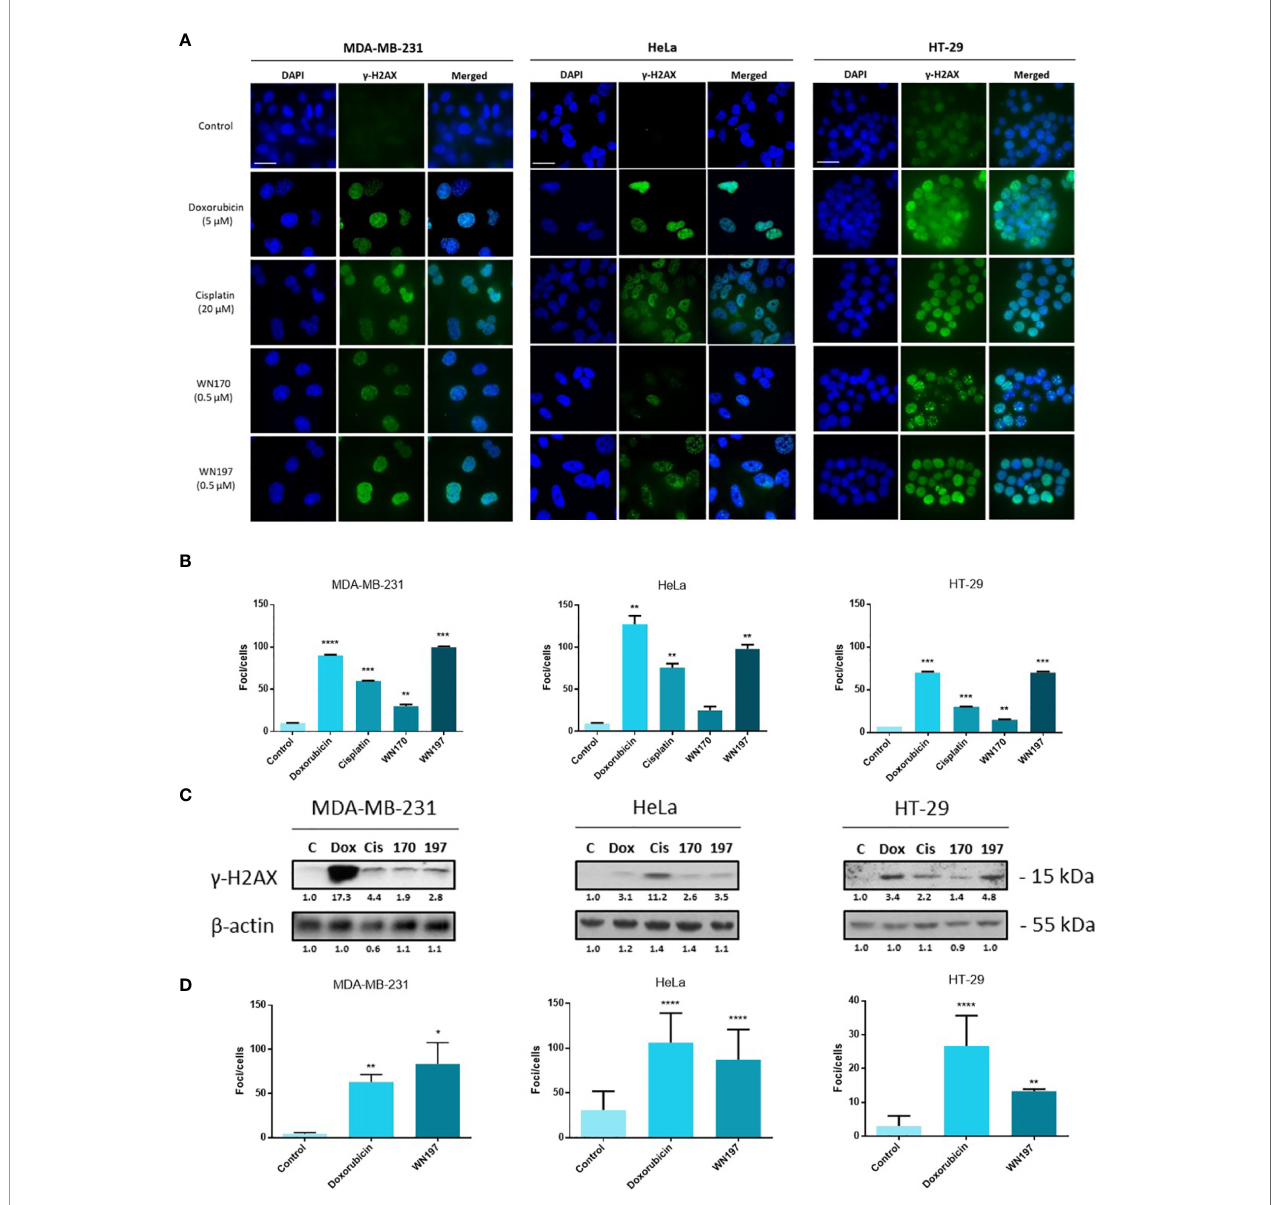
FIGURE 2 | The copper complex WN197 induced DNA damage in cancer cells. MDA-MB-231, HeLa and HT-29 cells were treated with DMSO (0.5%, solvent control), doxorubicin (5 µM, Top2 inhibitor inducing DNA breaks), cisplatin (20 µM, alkylating agent inducing DNA breaks), WN170 (0.5 µM, indenoisoquinoline without metal) or WN197 (0.5 µM). (A) Immuno fl uorescence of the DNA breaks marker g H2AX was visualized as green foci in nuclei stained with DAPI (blue) on a Leica fl uorescent microscope 24 h after treatments. Images were representative of three independent experiments. Scale bar: 20 µm (B) Quanti fi cation of g H2AX foci number per cells. (C) Western blot analysis of g H2AX 24 h after treatments. b -actin was used as a loading control and relative g H2AX level was quanti fi ed by densitometry using Image J (Fiji Software, v1.52i). (D) Quanti fi cation of g H2AX foci number per cells 30 min after treatments, based on immuno fl uorescence experiments. In B and D, data were expressed as the mean ± SD for 30 nuclei of three independent experiments. Statistical analyses were based on a two-way ANOVA followed by a Dunnett ’ s test (*p<0.05, **p<0,01, ***p<0,005 and